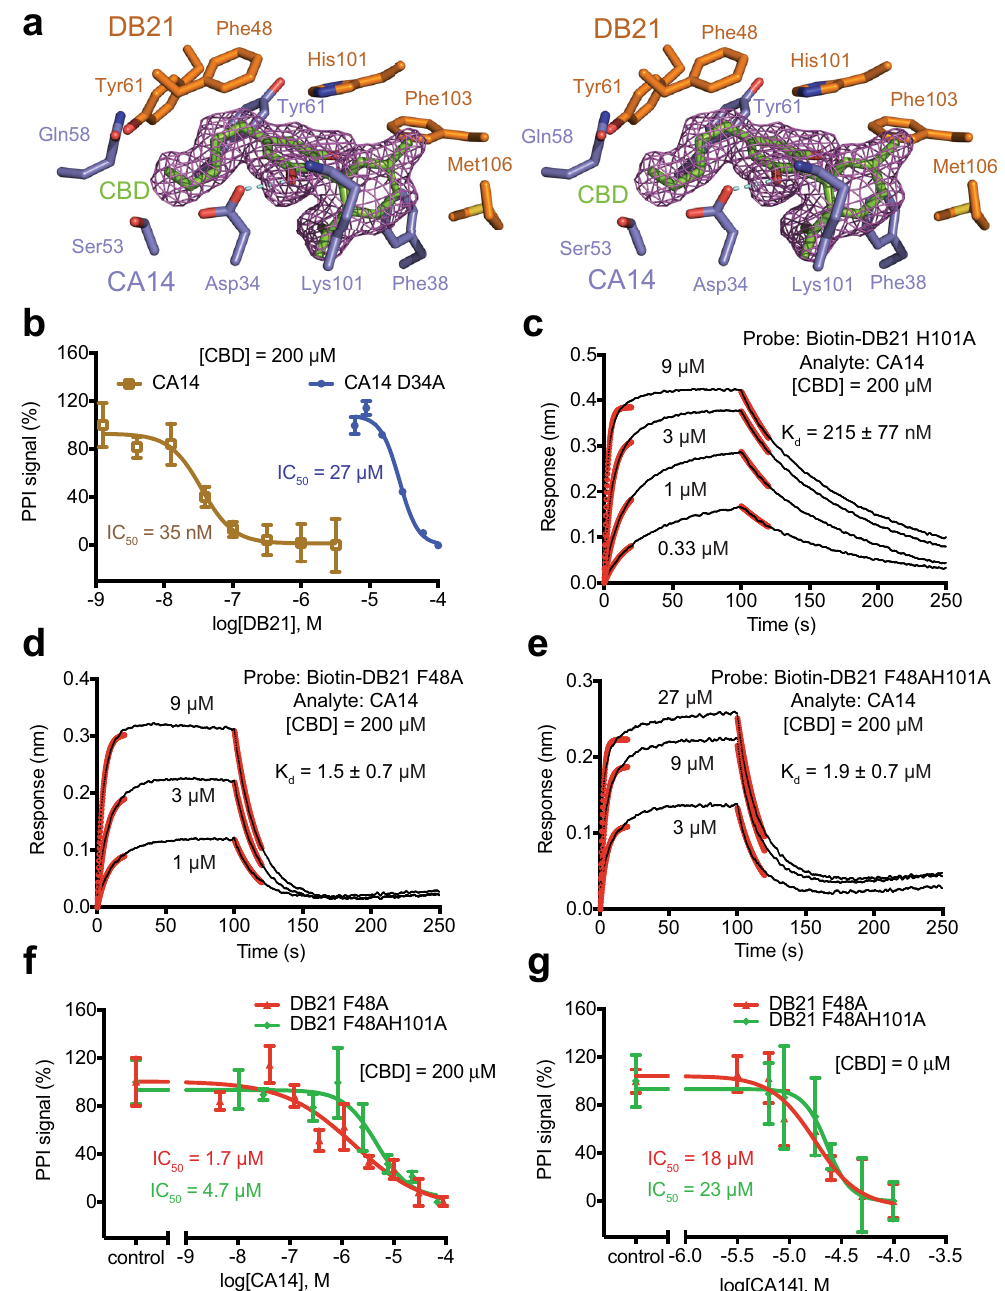
Fig. 4 Mutational analysis of CBD dual-nanobody sensor. a A close-up stereo view of CA14 and DB21 residues interacting with CBD (green and red sticks) with its positive F o − F c electron density contoured at 1 σ (purple mesh). CA14 (blue) and DB21 (orange) residues are shown in the stick model. The hydrogen bond between CA14 Asp34 and CBD are represented by cyan dashes. b AlphaScreen competition assays for assessing the effect of D34A mutation in CA14 (WT CA14 in brown and CA14 D34A mutant in blue) on ternary complex formation with CBD at a saturating concentration. Data were presented as mean ± s.d. of n = 3 biologically independent samples. IC 50 , half-maximum inhibitory concentration. Source data are provided as a Source Data fi le. c – e BLI analyses for assessing the effects of H101A, F48A, and F48A-H101A mutations in DB21 on ternary complex formation with CBD at a saturating concentration. Red lines represent curve fi tting at the initial phase of association and dissociation. K d , dissociation constant. Source data are provided as a Source Data fi le. f , g AlphaScreen competition assays for assessing the effects of F48A (red) and F48A-H101A (green) mutations on CA14 – DB21 interaction in the presence or absence of CBD at a saturating concentration. Data were presented as mean ± s.d. of n = 3 biologically independent samples. IC 50 , half-maximum inhibitory concentration. Source data are provided as a Source Data fi